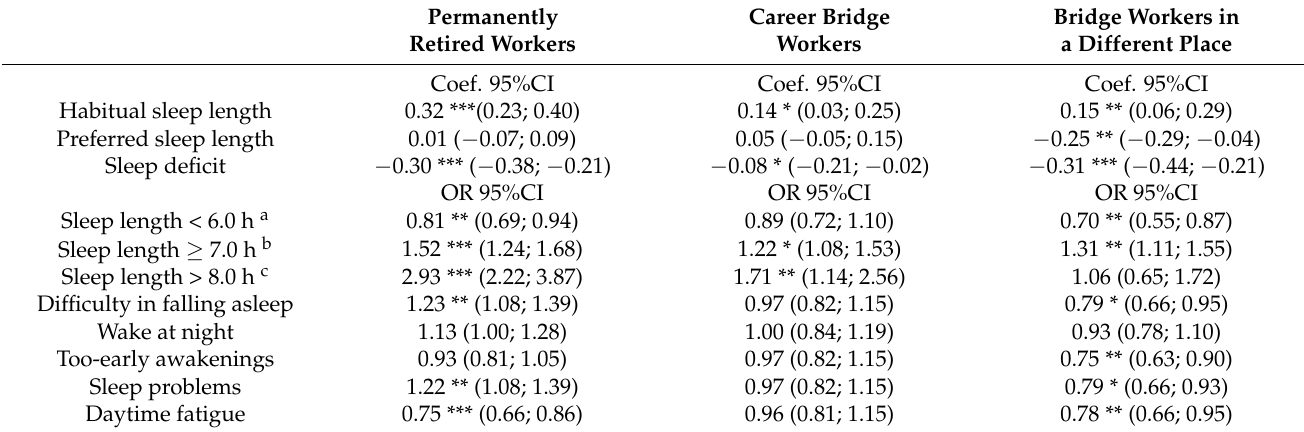
Table 2. Regression models for sleep/wake characteristics in retired workers compared with active ones. Longitudinal Study of Adult Health